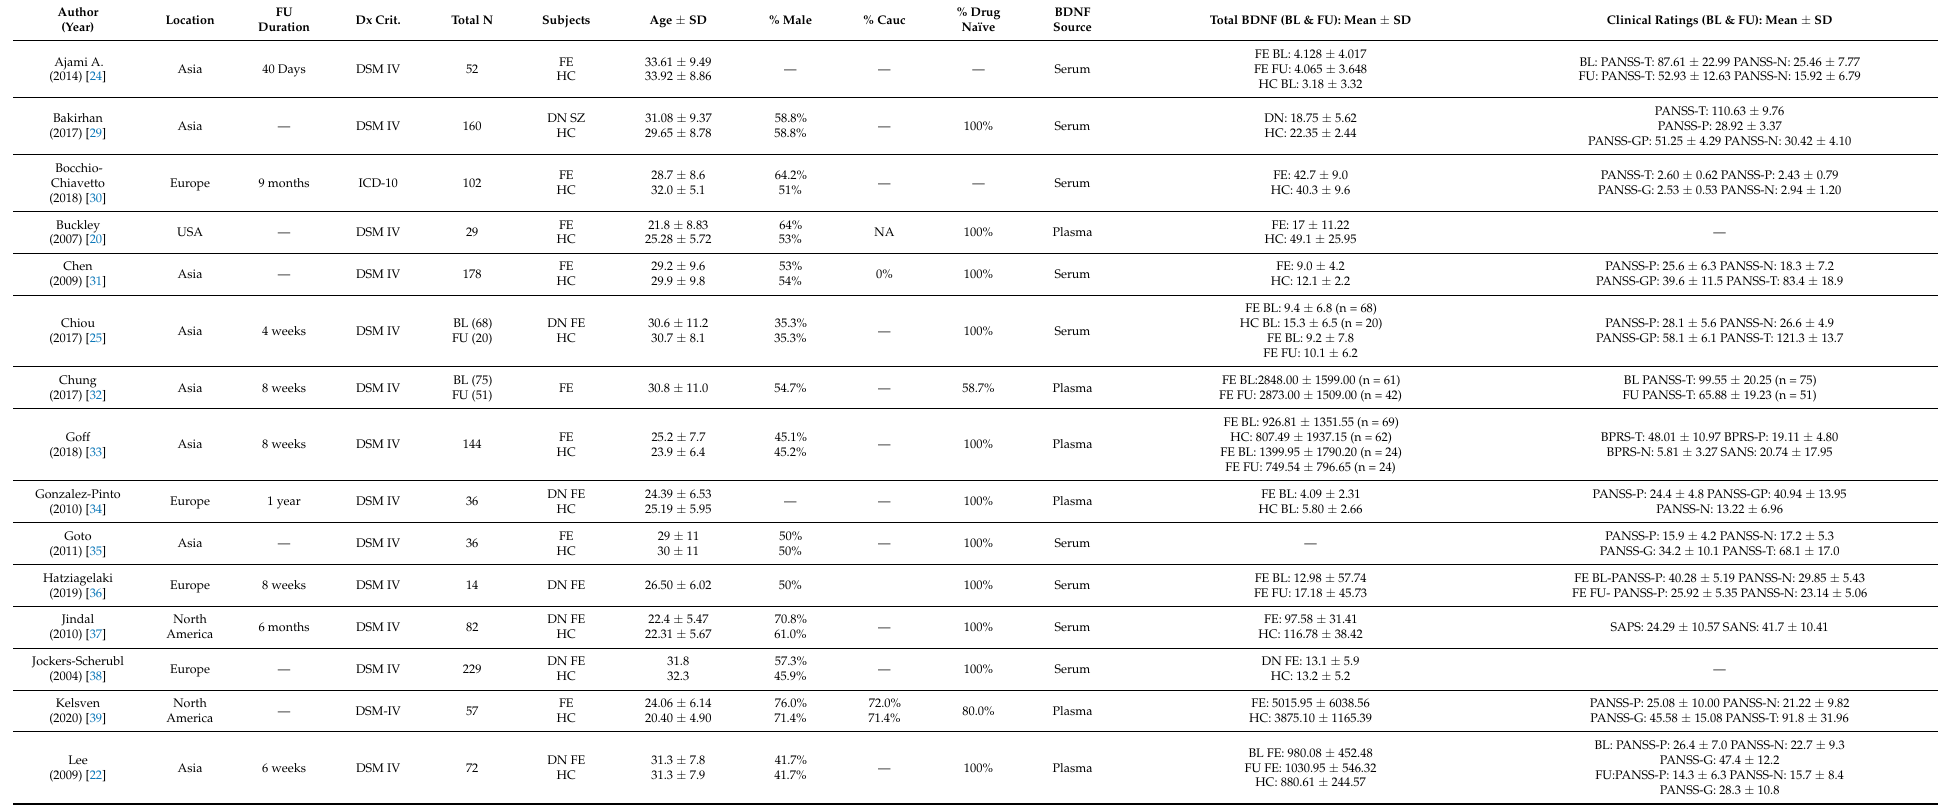
Table 1. Demographical data of included studies.